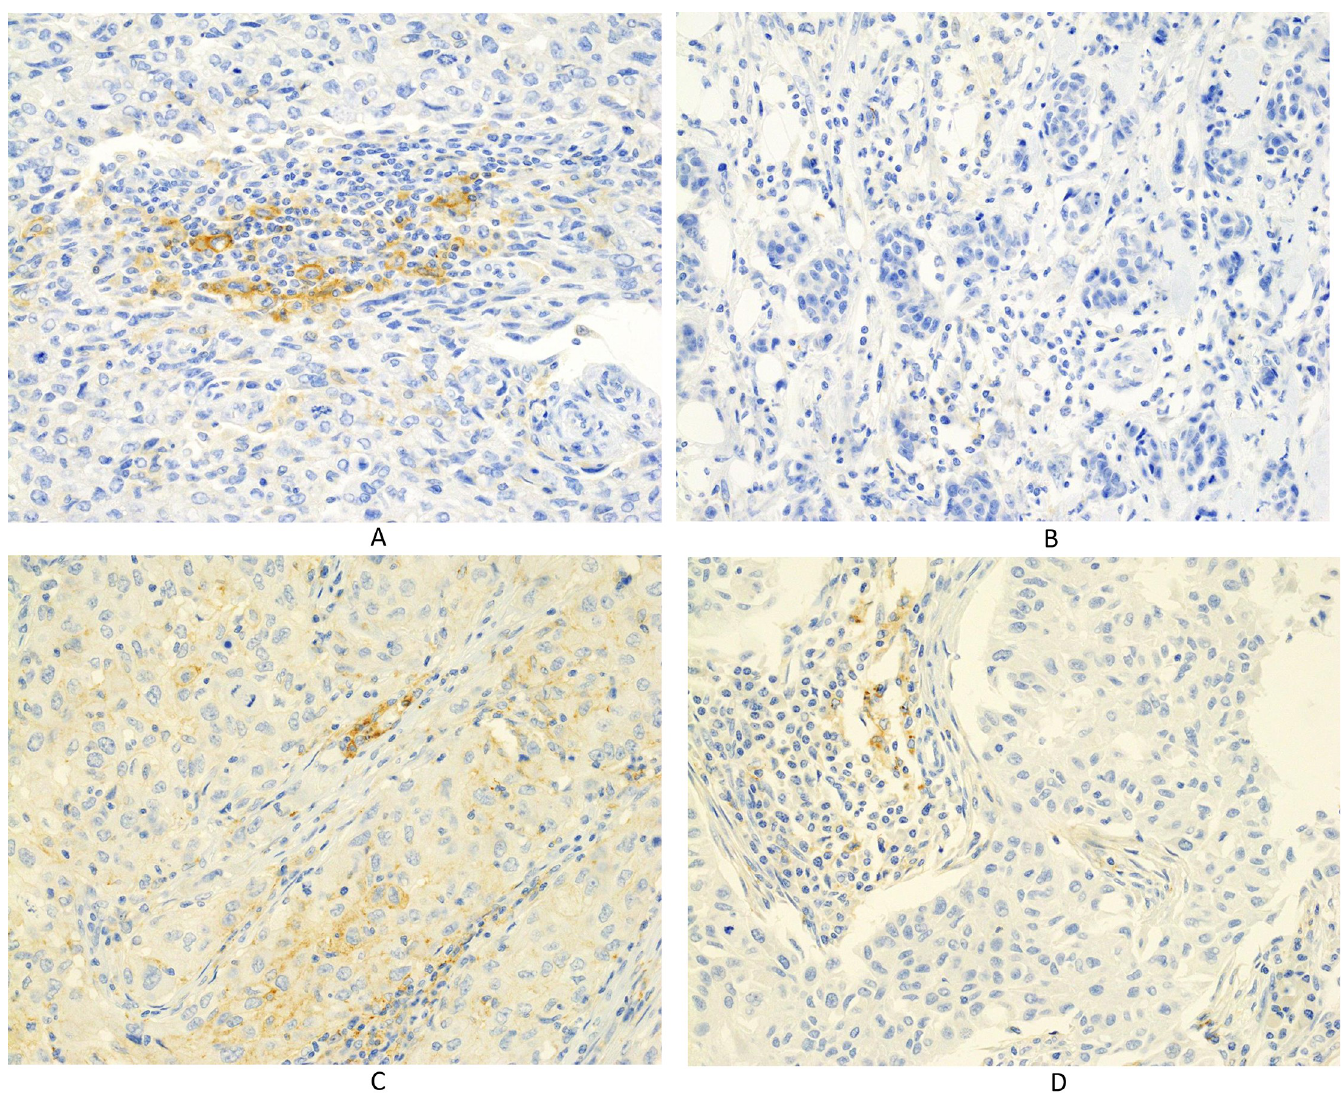
Fig 3. Immunohistochemical staining for PD-L1 using the E1L3N assay. (A) PD-L1 is expressed in immune cells ( × 400). (B) No PD-L1 expression is noted in immune cells ( × 400). (C) PD-L1 is expressed in carcinoma cells ( × 400). (D) PD-L1 is not expressed in carcinoma cells (x 400).